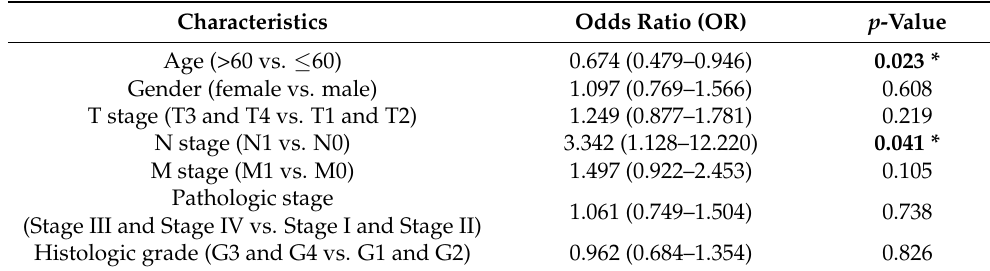
Table 1. Correlations between PTX3 expression and clinicopathological characteristics in TCGA-KIRC.